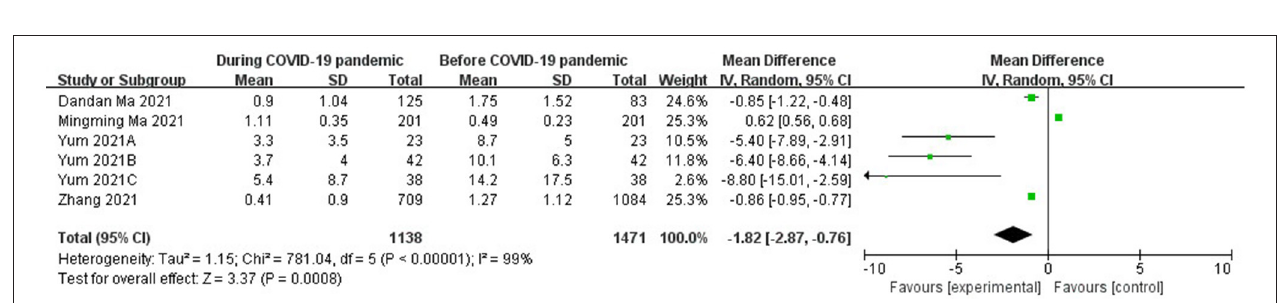
FIGURE 5 | Forest plots for comparison of outdoor activities time between COVID-19 pandemic and before it.